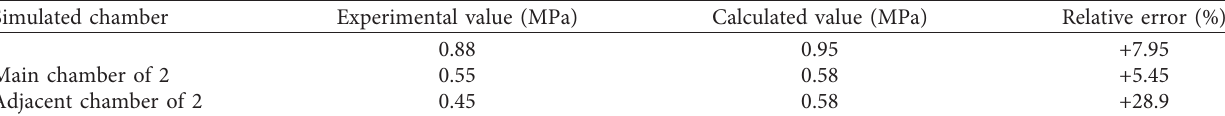
Table 3: Comparison of experimental and calculated values of quasistatic peak